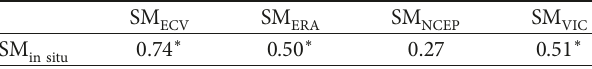
Table 3: The correlation coefficients between the SM in situ data and theSM ECV ,theSM ERA ,theSM NCEP ,andtheSM VIC data,respectively. They are computed from the seasonally averaged time series during 1988–2010 within the typical study region. The asterisk indicates that the correlation coefficient passes the significance test at 5% level.